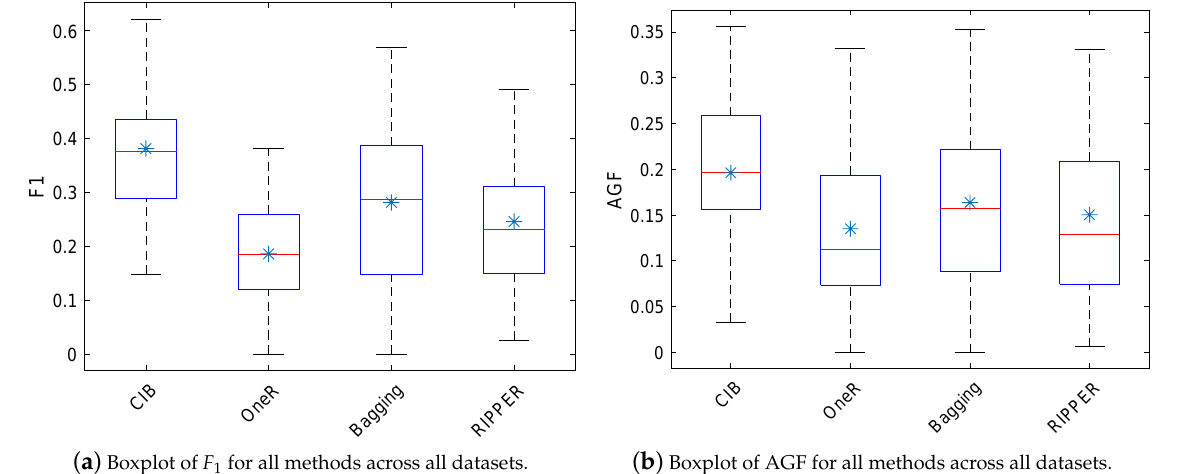
( a ) Boxplot of F 1 for all methods across all datasets.